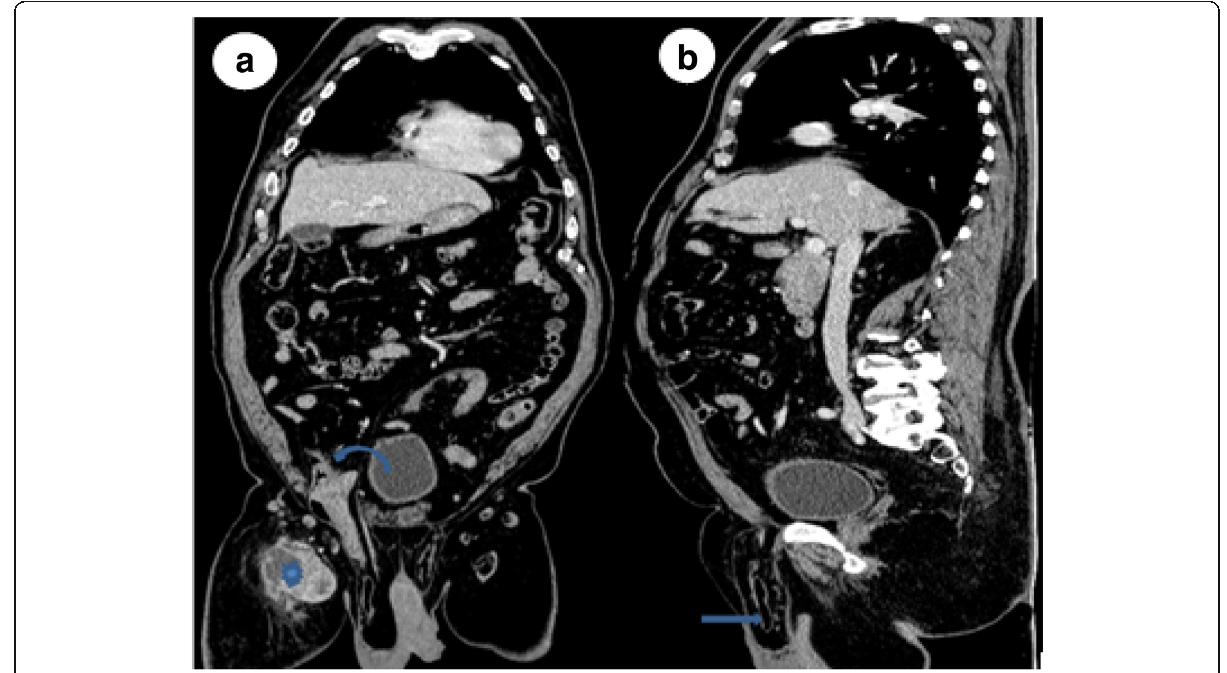
Fig. 1 a , b CT abdomen coronal and sagittal sections venous phase shows terminal ileum, cecum, and normal appendix inside the right inguinal canal. Also noted is right femoral necrotic lymph nodal metastasis from the malignant melanoma (straight arrow indicates appendix in the right scrotal region, curved arrow indicate ileocecal junction, star indicates necrotic lymph nodal